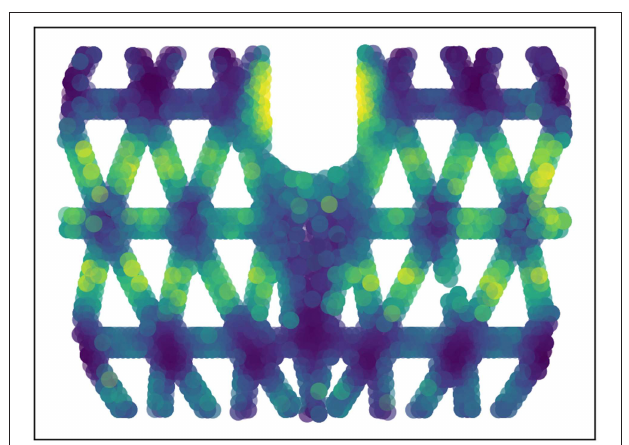
FIGURE 3 | Rigidness analysis of the 3D structure: the same force is applied on each point on the surface and the displacement is compared. Lighter colors indicates bigger displacements and less rigidity (normalized for